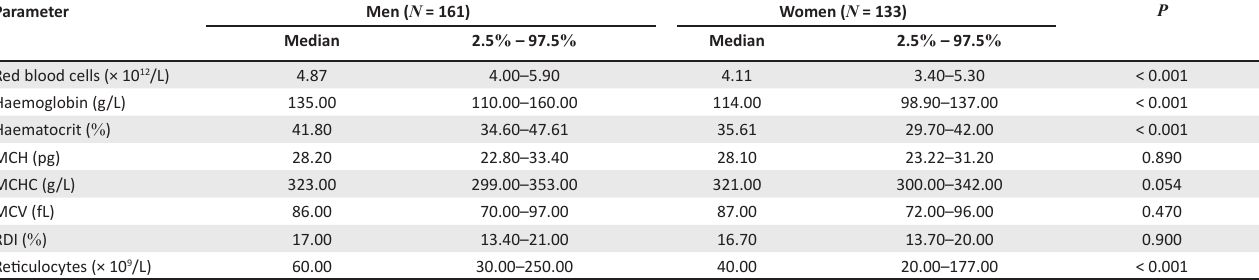
TABLE 3: Erythrocyte parameters for men and women, Yaoundé, Cameroon, November 2015 – September 2016. Parameter